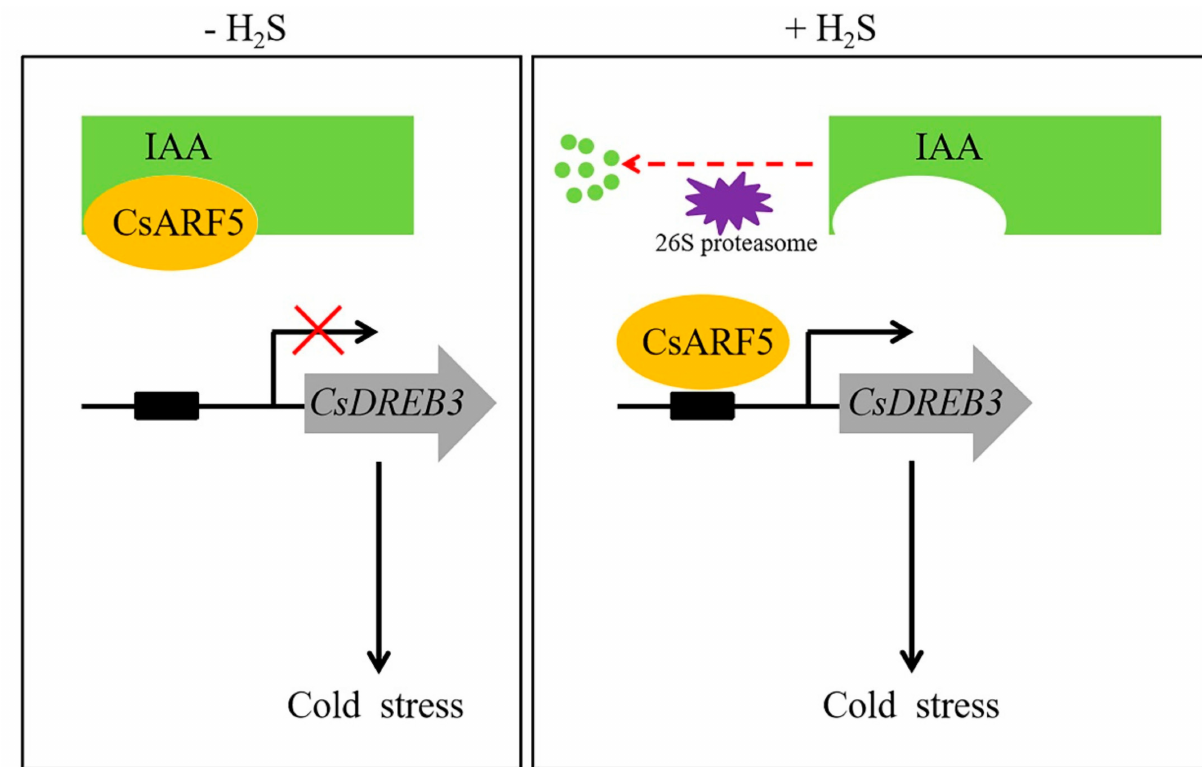
Figure 9. A regulatory model elucidates that H 2 S mediates the cold stress response in cucumber through auxin signaling. In the absence of H 2 S, IAA repressor proteins inhibit the expression of CsARF5, which in turn inhibits the cold stress response mediated by the CsARF5- CsDREB3 module. In the presence of H 2 S, IAA repressor proteins release CsARF5, which promotes the cold stress response by activating CsDREB3